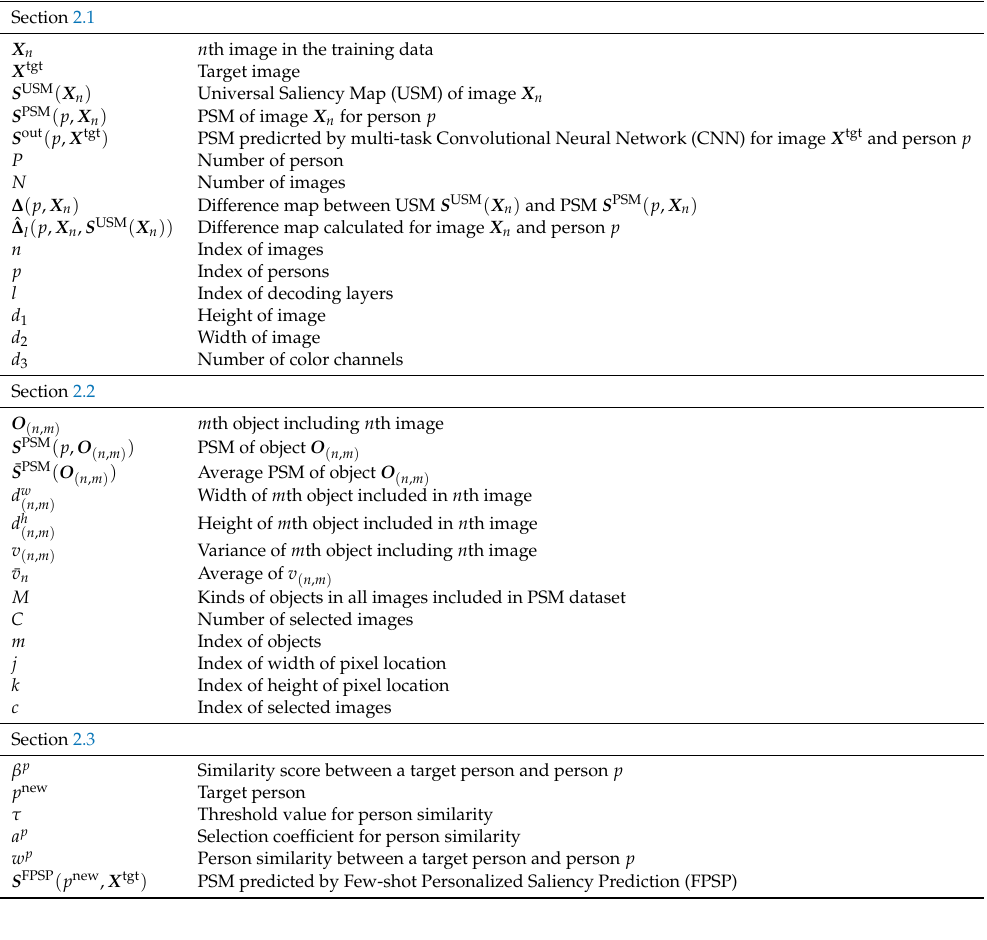
Table 1. The list of variables used in Section 2.